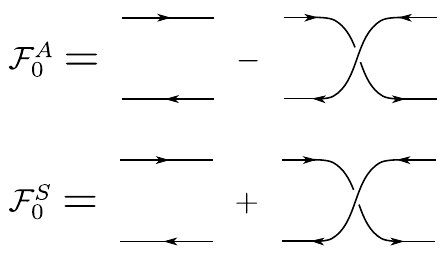
Figure 5 . Odd and even zero-rung four-point